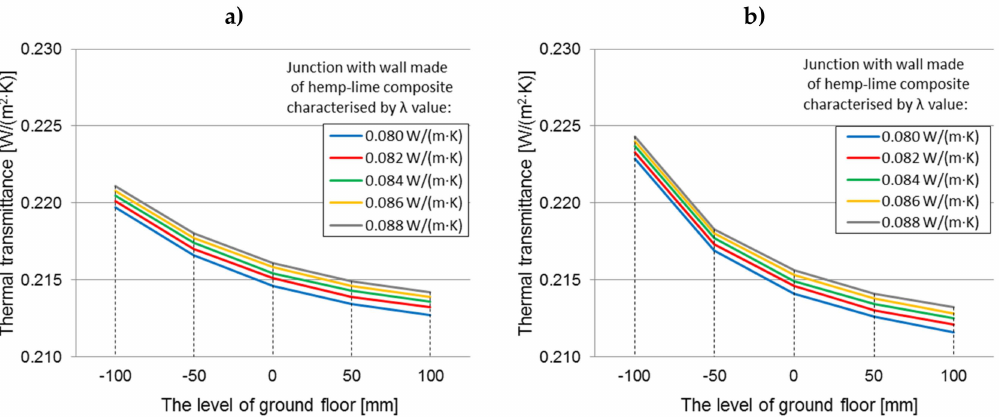
Figure 8. Averaged thermal transmittance coe ffi cient of ground junction with “400c” wall filled with a hemp–lime composite with values of λ = 0.08–0.088 W / (m · K), depending on the floor level on the ground: ( a ) floor on joists, ( b ) self-supporting